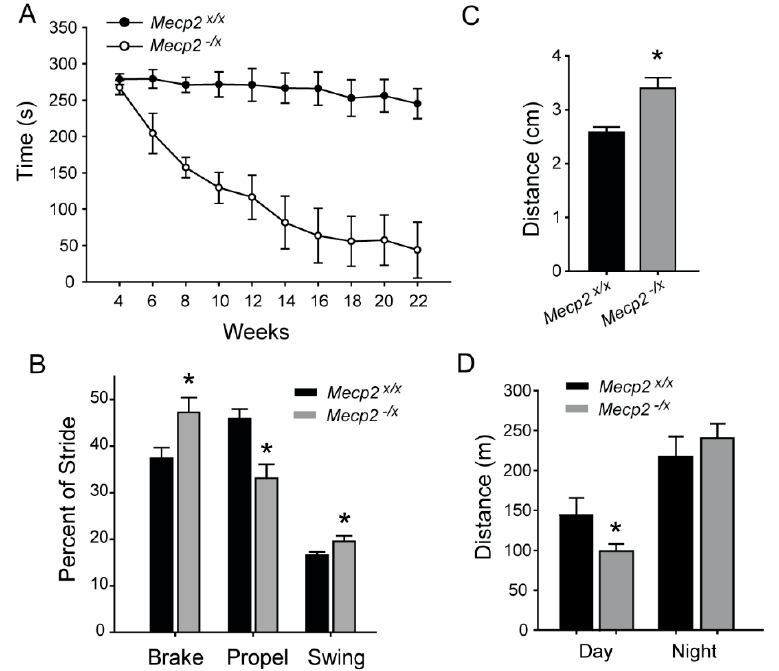
Figure 1. Motor impairments in RTT. ( A ) Biweekly measurements of Rota-rod performance in WT Mecp2 x/x and Mecp2 − /x rats. Two-way repeated measure Analysis of Variance (ANOVA) reveals significant difference at all ages starting from six weeks ( p < 0.001); Holm-Sidak post hoc comparisons ( n = 10 per group). See Table 1 for statistical details; ( B ) Forepaw gait analysis using the DigiGait system in WT and Mecp2 − /x . Comparison by t -test reveals significant difference between the two groups in Brake (* p = 0.021), Propel (* p = 0.0027) and Swing (* p = 0.024), expressed as percentage of Stride, as measured from the forepaw; ( C ) Hind paw stance width of the mutant animals was greater (* p = 0.0009, t -test). n : Mecp2 x/x =10 and Mecp2 − /x = 6 for ( B ) and ( C ); 4 Mecp2 − /x animals were excluded because they could not stay on the DigiGait treadmill; ( D ) Difference in distance traveled in a 24-h period by the rats, split between the day and night cycle. Mutant rats are hypoactive during the day (* p = 0.037), but show no difference relative to wildtype at night ( p = 0.434) ( n = WT = 5 and Mecp2 − /x = 10). All graphs represent Mean ± SEM.